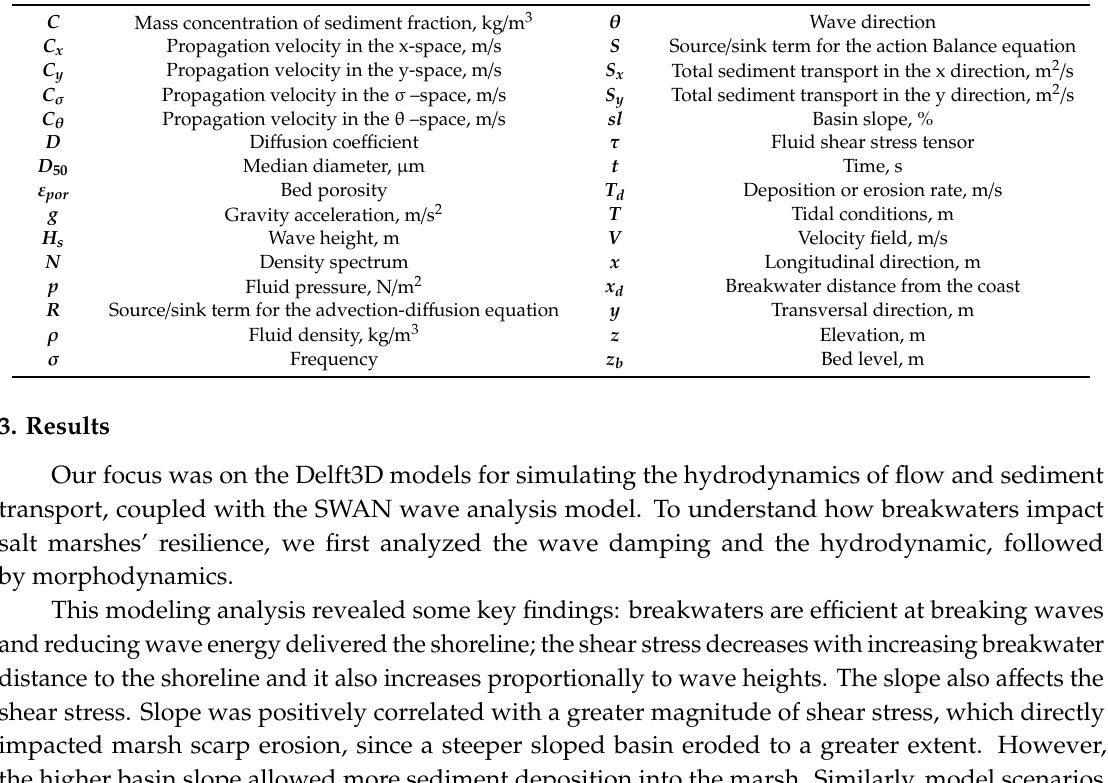
Table 2. Notation of coe ffi cients of Equations (1)–(5) and Table